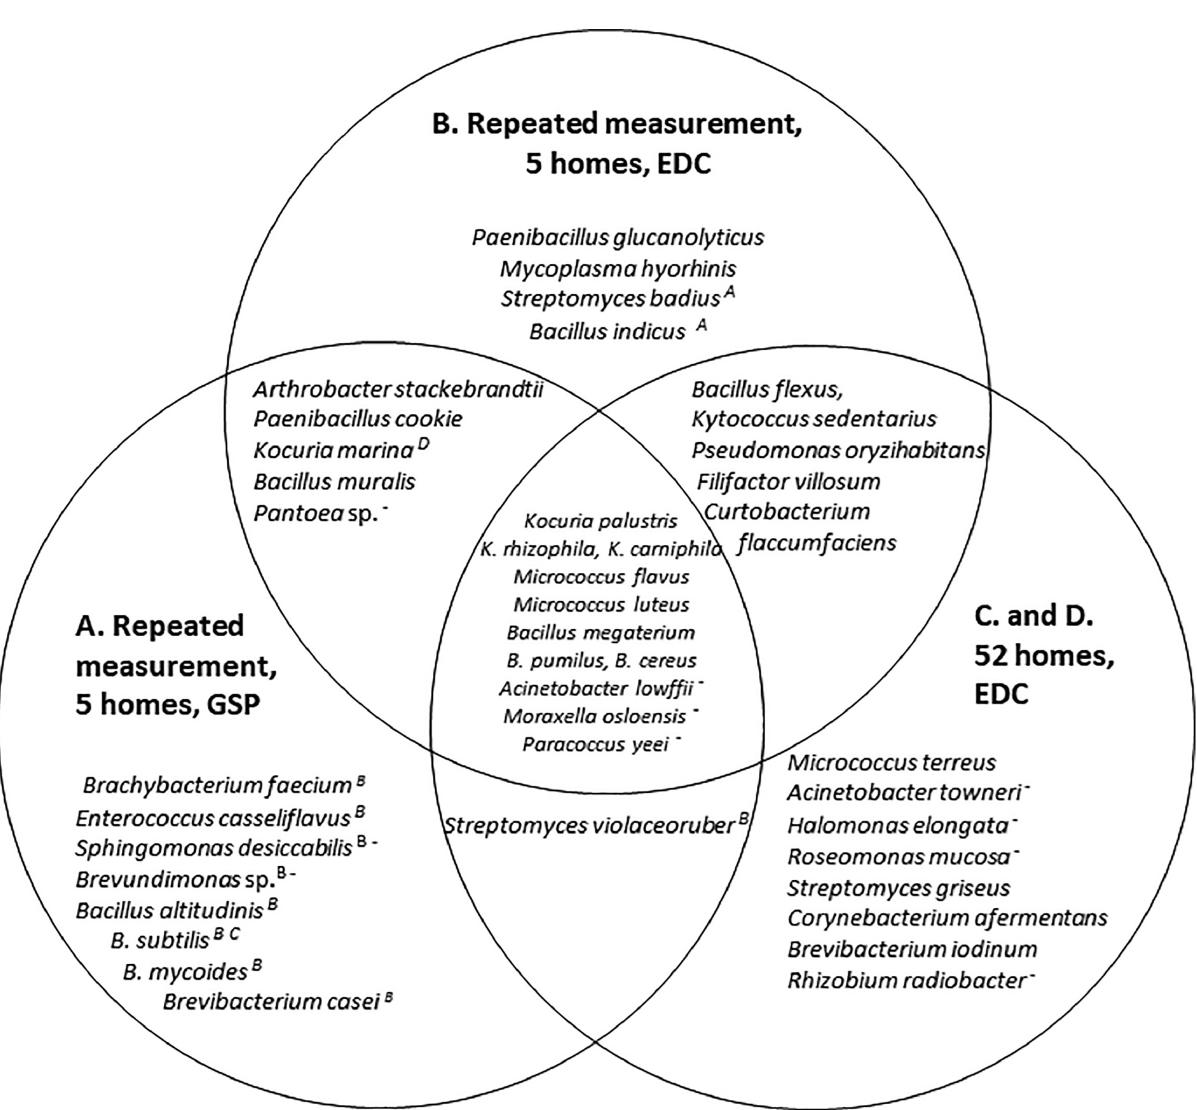
The 25 dominating bacterial species in samples from the living room in five homes with repeated measurements using GSPs (A) for sampling once per season using EDCs (B), and once in the living room of 24 (C) and 28 (D) homes using EDCs. The A, B, C and Ds following some bacterial names indicate that the bacterium has also been found in studies A, B, C or D – but not among the 25 dominating species, and the symbol ‘–’ indicates that the bacterium is Gram-negative. (Source: Authors,